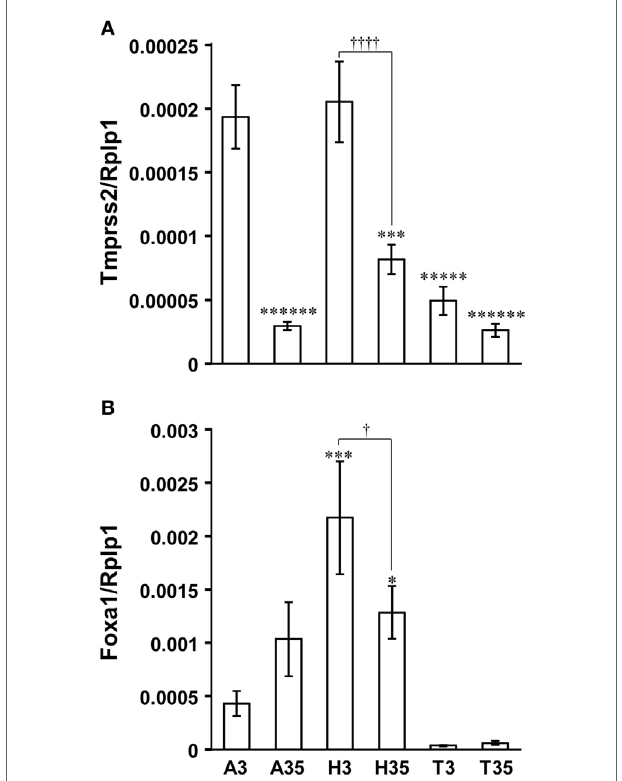
FigUre 6 | Developmental changes in Tmprss2 and Foxa1 gene expression in the amygdala, hypothalamus, and telencephalon excluding amygdala and hippocampus of male rat. (a) The ratio of Tmprss2 gene expression level relative to a housekeeping gene, Rplp1. Each column and the vertical line represent the mean ± SEM ( n = 5 samples, one sample from one rat). ****** P < 0.000001; ***** P < 0.00001, *** P < 0.001 vs. amygdala of P3 male rat (A3) by one-way ANOVA followed by Fisher’s protected least significant difference (PLSD) test. †††† P < 0.0001, hypothalamus of P3 male rat (H3) vs. hypothalamus of P35 male rat (H35) by Student’s t -test. A35, amygdala of P35 male rat; T3, telencephalon excluding amygdala and hippocampus of P3 male rat; T35, telencephalon excluding amygdala and hippocampus of P35 male rat. (b) The ratio of Foxa1 gene expression level relative to Rplp1. Each column and the vertical line represent the mean ± SEM ( n = 5 samples, one sample from one rat). *** P < 0.001; * P < 0.05 vs. A3 by one-way ANOVA followed by Fisher’s PLSD test. † P < 0.05, H3 vs. H35 by Student’s t